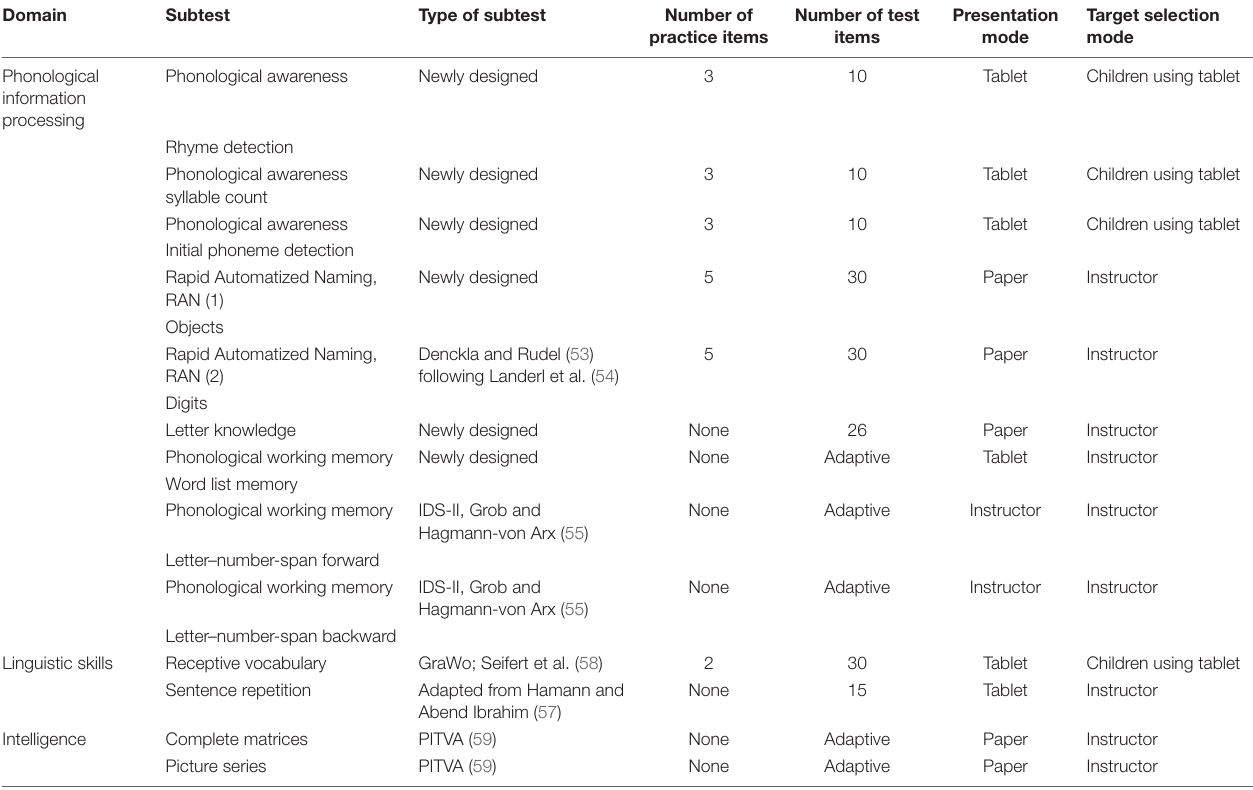
TABLE 1 | Subtests and domains of the screening measures. Domain Subtest Type of